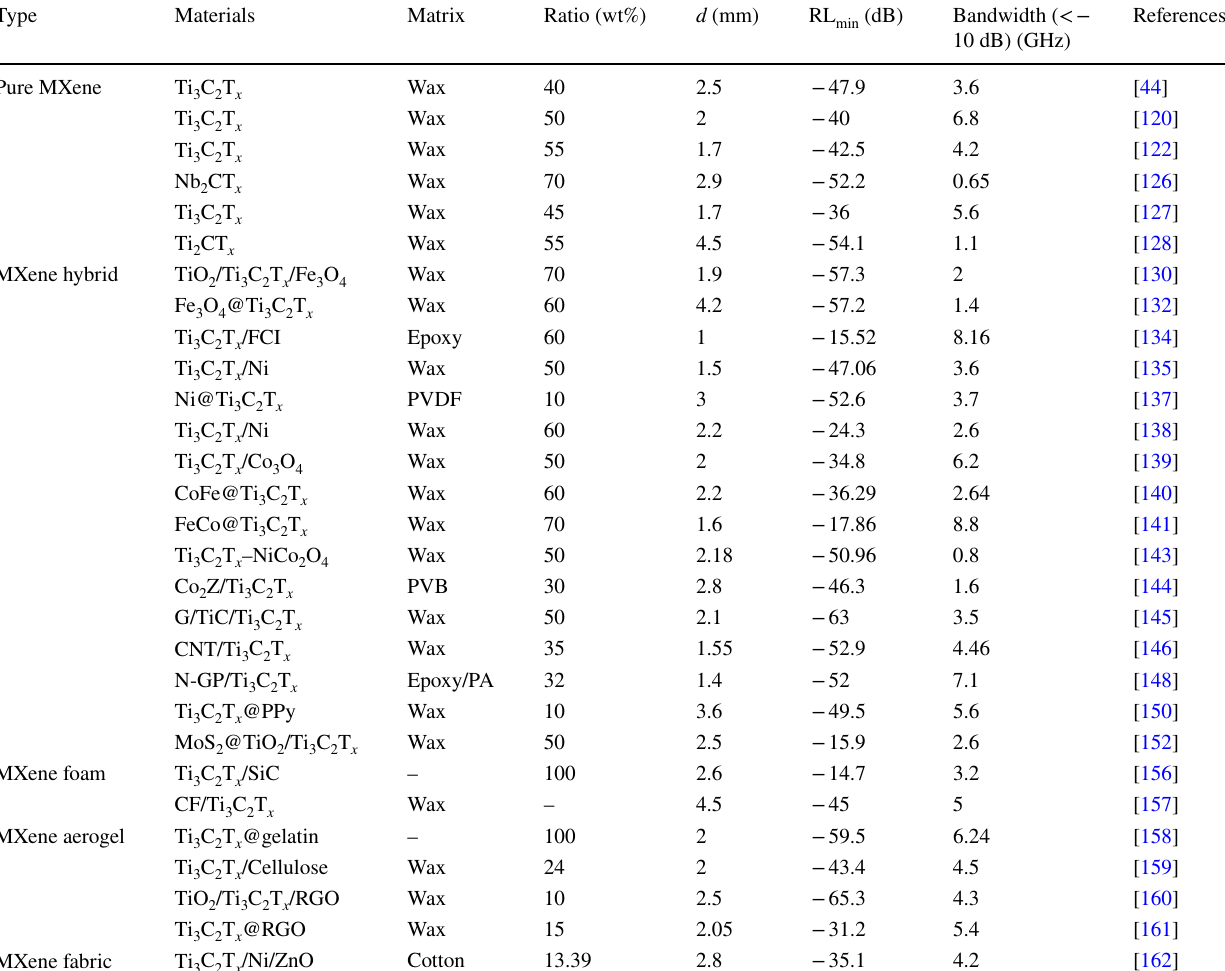
Table 3 Typical MXene‑based materials and their EM wave absorption properties